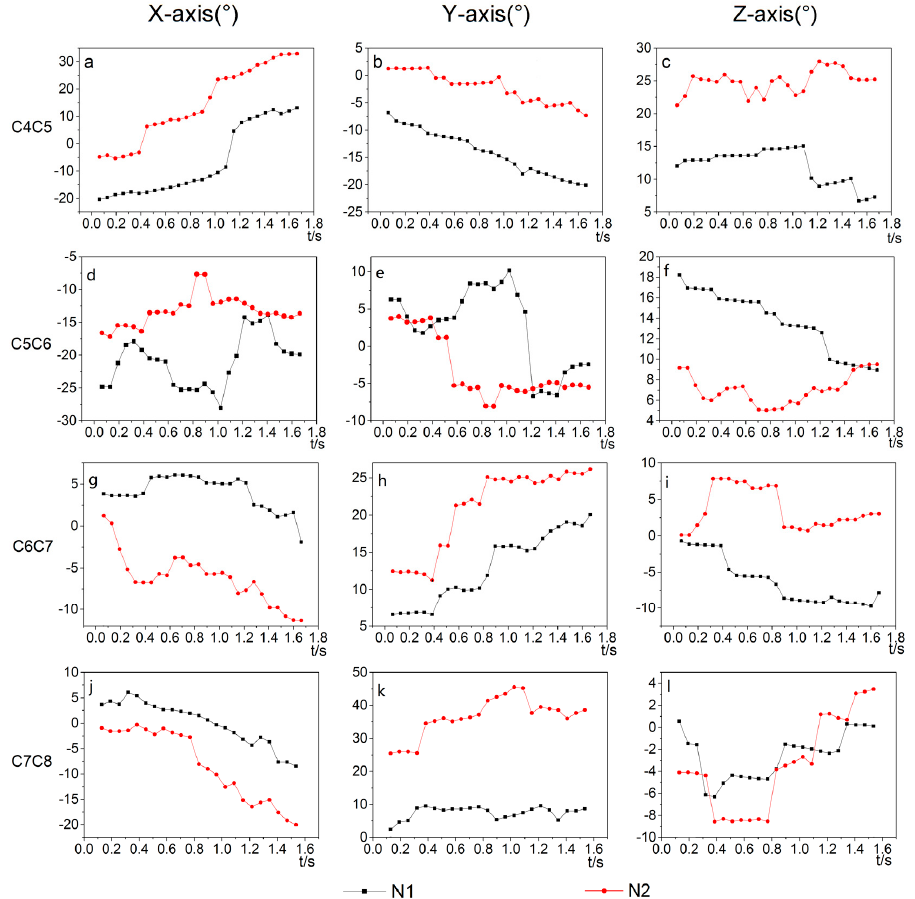
Figure 7. The angular three-dimensional displacement of joints C4/C5, C5/C6, C6/C7, and C7/C8 for two representative trails (N1, N2): ( a–c ) angle of C4/C5 around X, Y and Z axes, ( d–f ) angle of C5/C6 around X, Y and Z axes, ( g–i ) angle of C6/C7 around X, Y and Z axes, ( j–l ) angle of C7/C8 around X, Y and Z axes. As shown in Figure 7a − c, g − l, the cure trends of N1 and N2 for C4/C5, C6/C7, and Table 2. Data of each joint movement when moving the body in Z-direction. C7/C8 joints are roughly similar. In Figure 7d − f, the N1 and N2 curves for the C5/C6 joints show significant differences.